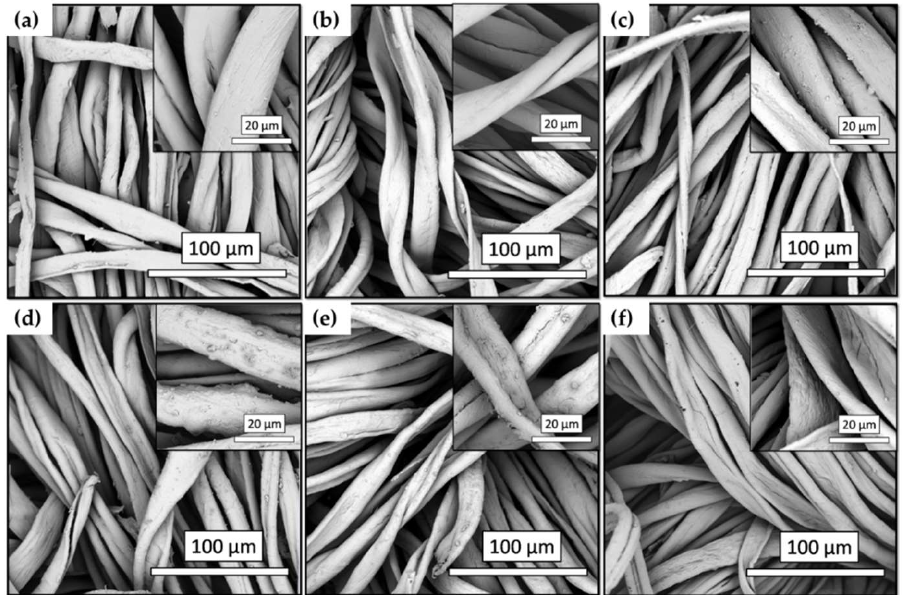
Figure 14. SEM images of untreated cotton ( a ) and GC2_C′2-coated, ( b ) GC8_C′8-coated, ( c ) GC16_C′16-coated, ( d ) GC2_C′16-coated, ( e ) GC8_C′16-coated, and ( f ) modified cotton fabrics (the inserts are partially enlarged images).